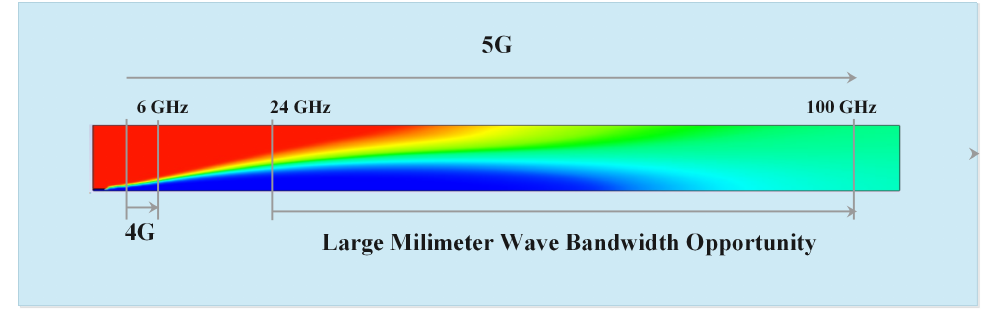
Figure 4. Pictorial representation of millimeter wave.